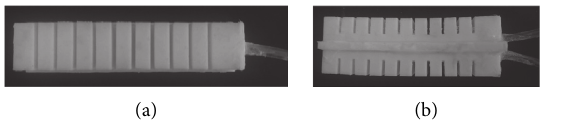
Figure 4: Physical model of pneumatic soft-bodied bionic basic execution unit. (a) Unidirectional basic execution unit. (b) Bidirectional basic execution unit.